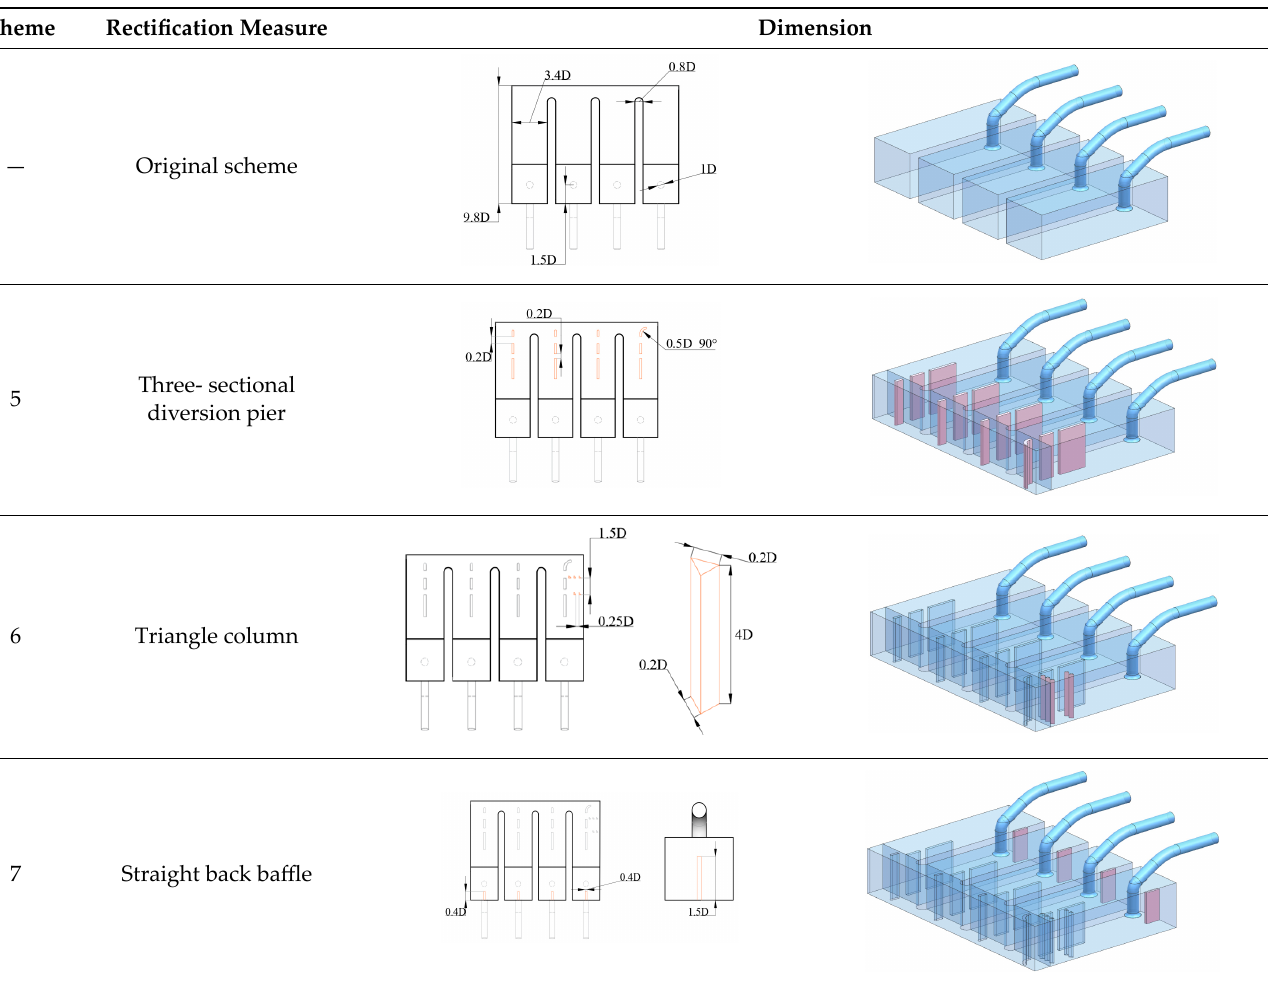
Table 2. Rectification measures in the